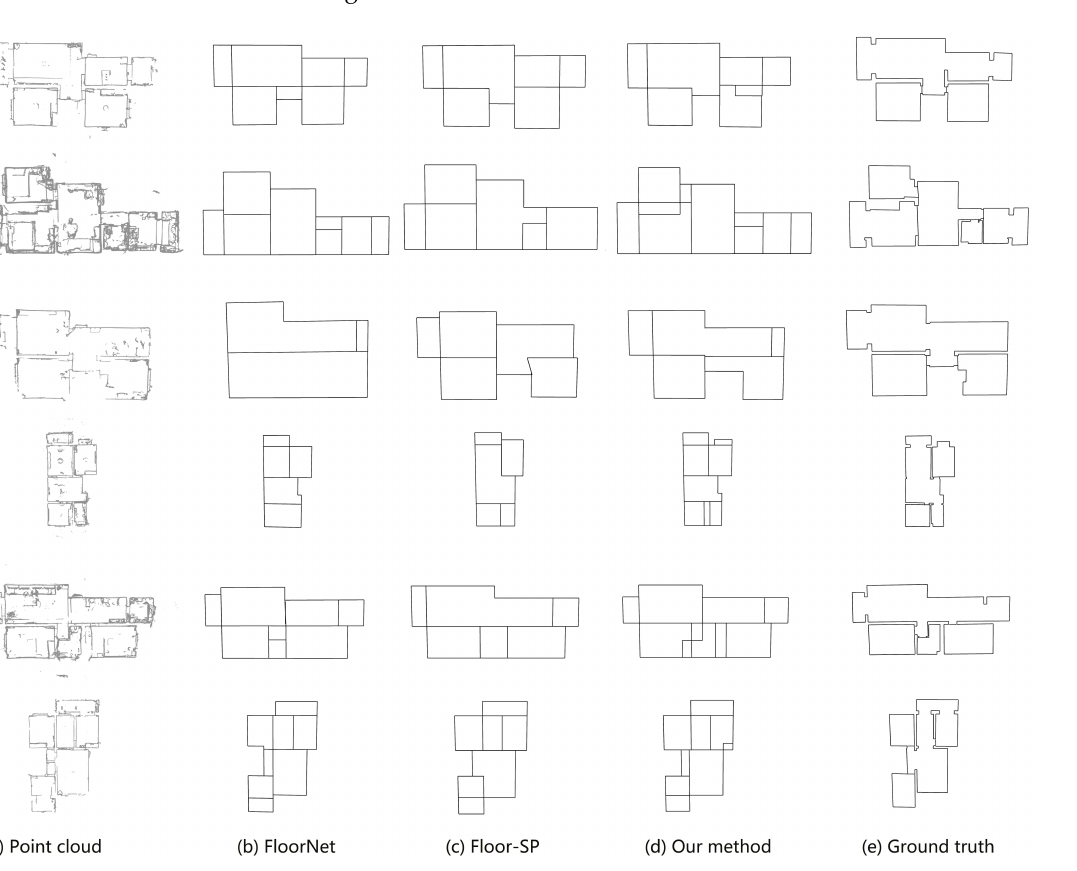
Figure 4. 2D floorplan reconstruction results of our method and learning-based methods for evaluated datasets. From left to right, we display the density map of the point cloud, the result of FloorNet, Floor-SP, and our method and ground truth,